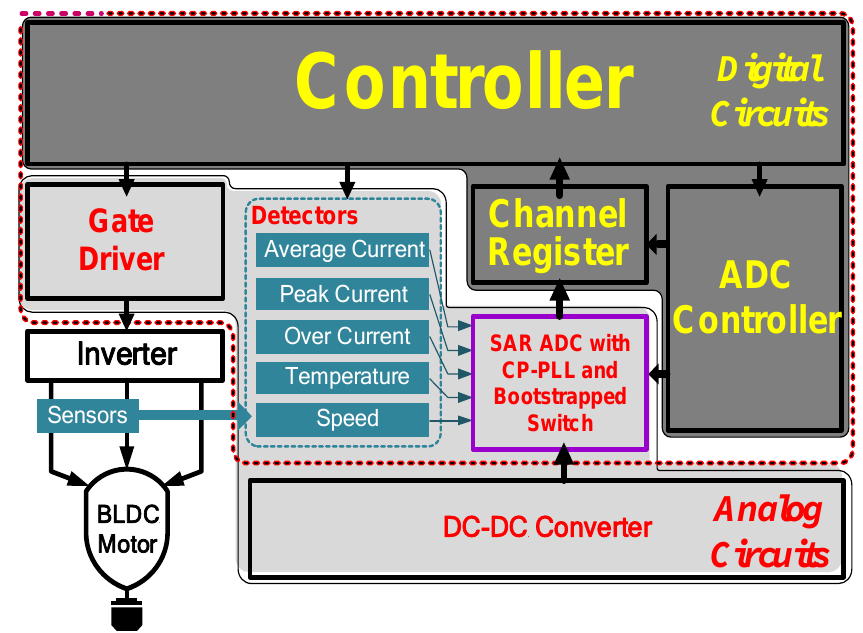
Figure 1. Proposed system block diagram of an electric vehicle for the BLDC motor drive.